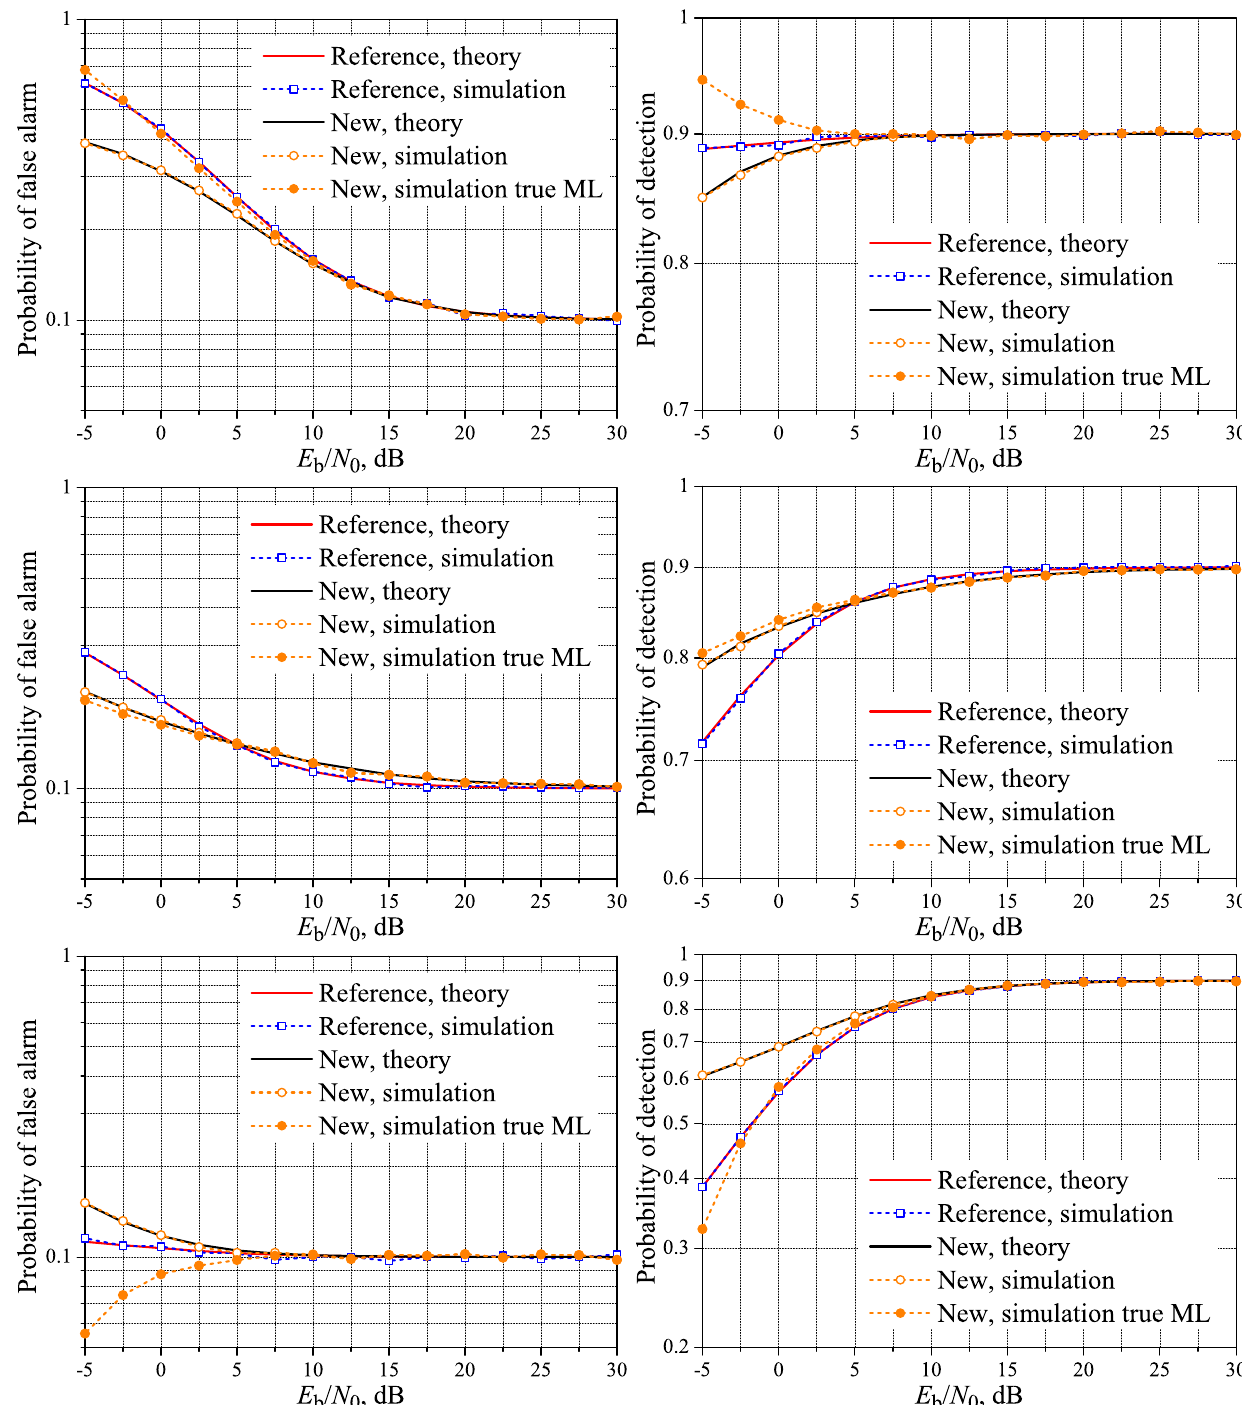
Figure 4. Spectrum sensing performance for the real-valued Rayleigh reporting channel. M = 3 and K = 1 ( top ); K = 2 ( middle ); and K = 3 ( bottom